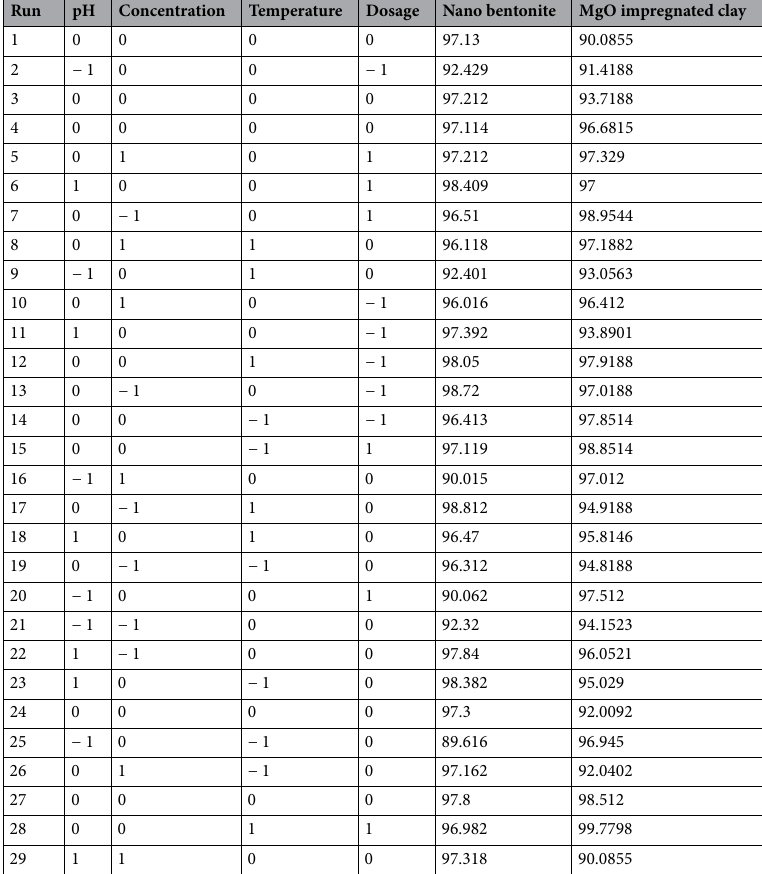
Table 2. Experimental design and results of the Box Ben design for the decolourization of MG by nano bentonite and MgO impregnated